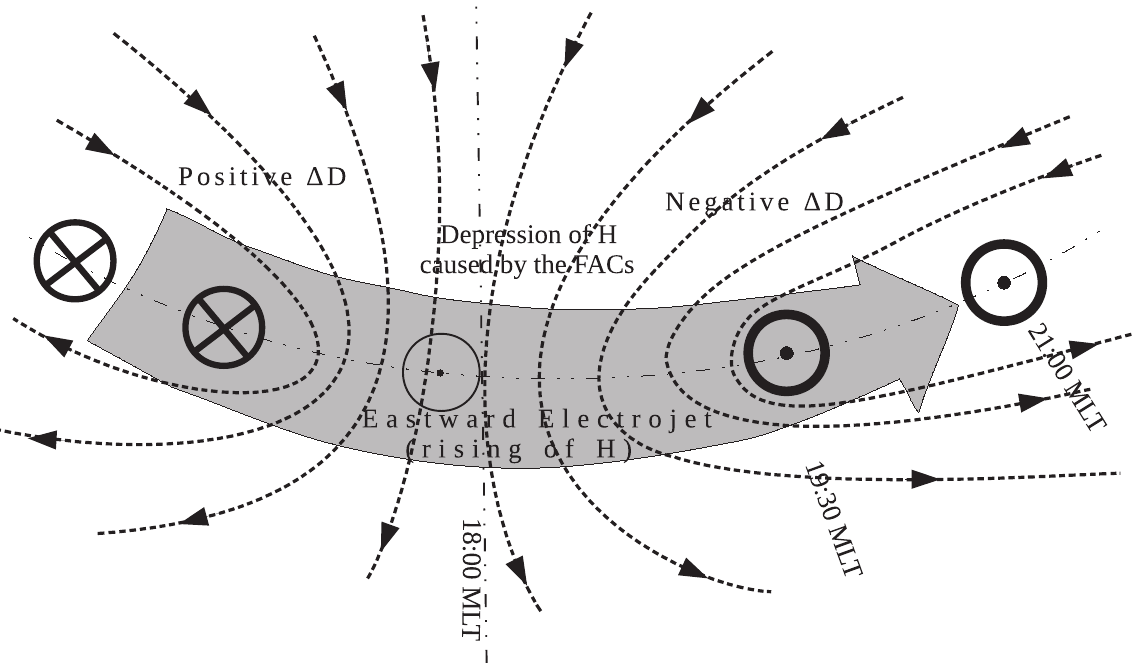
Fig. 5. The sketch of the situation during the geomagnetic storm at Greenwich on 4 February 1872. The circle with the dots in their centres indicate the position of the FAC fl owing upward, the circles with crosses mark the FAC fl owing downward. The boldness of the marks expresses the intensity of the electric currents. The dashed lines represent the lines of force of the magnetic fi eld that is generated by the FACs. The D D sign stands for the deviation of the magnetic declination. Here we assume that the eastward electrojet fl owed at lower magnetic latitudes than is the magnetic latitude of